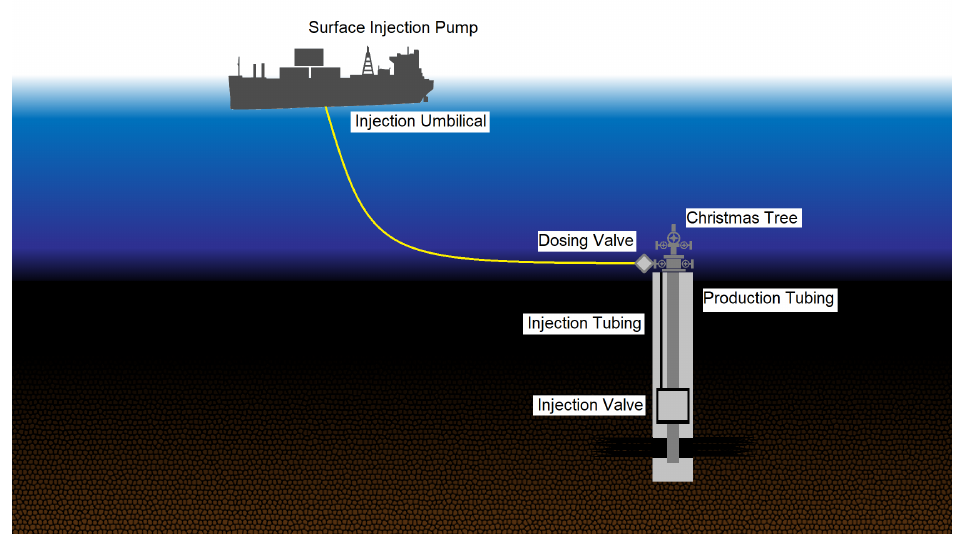
Figure 3. Schematic of an offshore downhole chemical injection